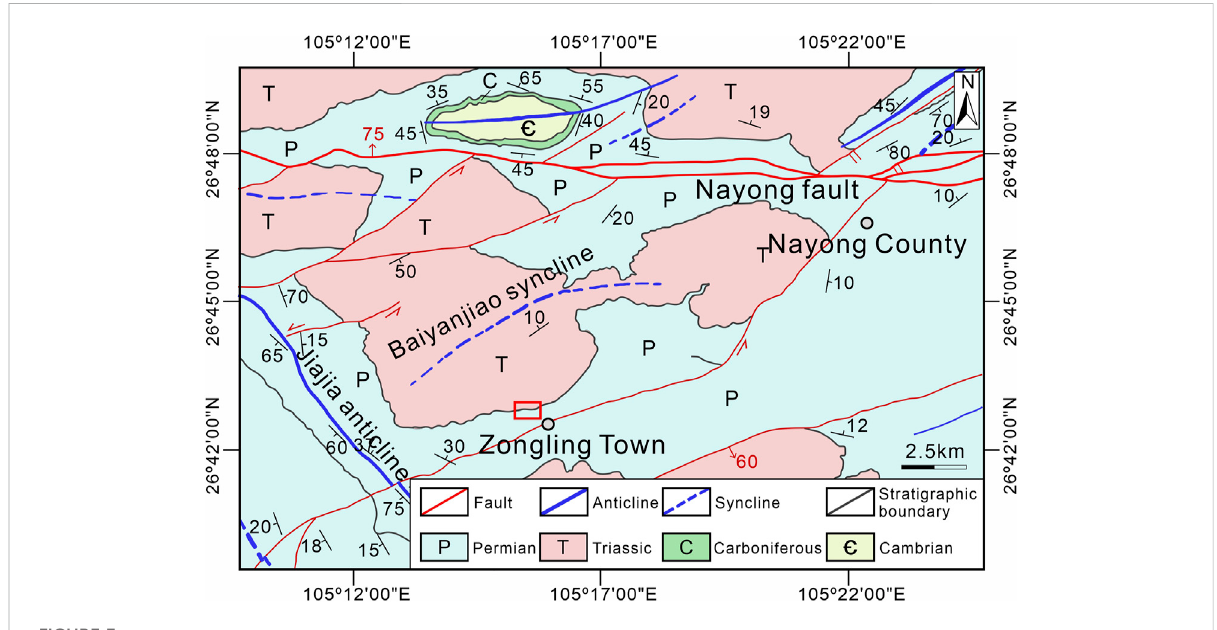
FIGURE 3 Regional tectonic and lithology map (modi fi ed from the work of Wu et al.,